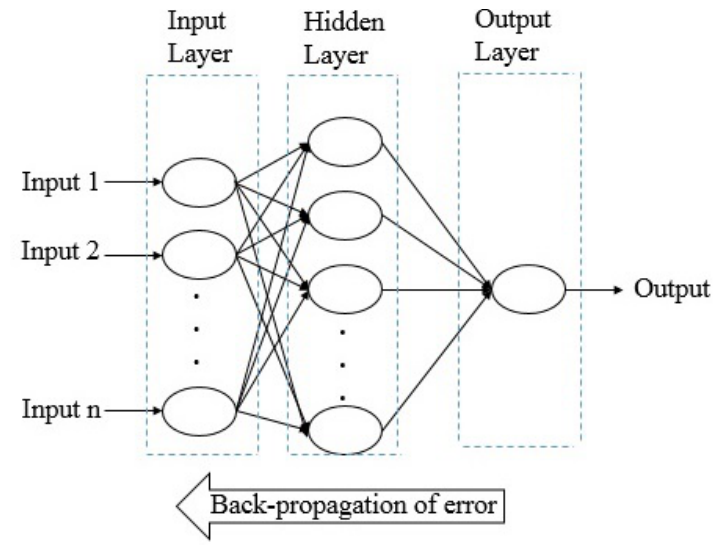
Figure 5. The structure of the